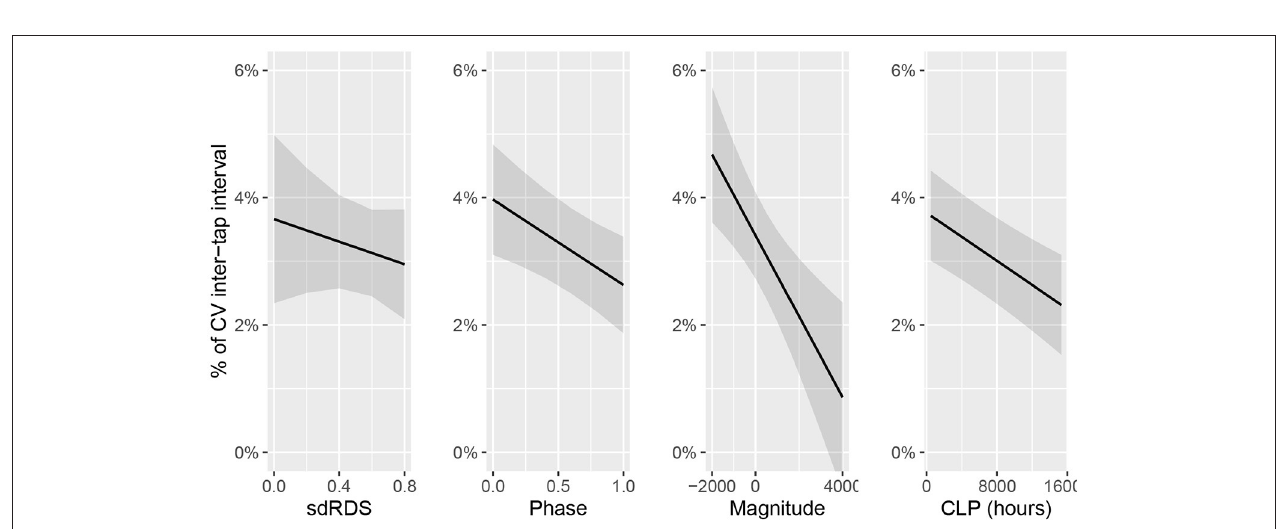
FIGURE 9 | Predicted change in CV-ITI based on sdRDS, Phase, Magnitude, and CLP. The plot shows that more CLP predict lower CV-ITI. Stronger relative flexor activity compared to extensor activity, as well as engagement of flexor and extensor muscles in anti-phase also predict steadier performance. The predictive power of sdRDS seems to be better captured in Phase and Magnitude separately. Bands represent 95%